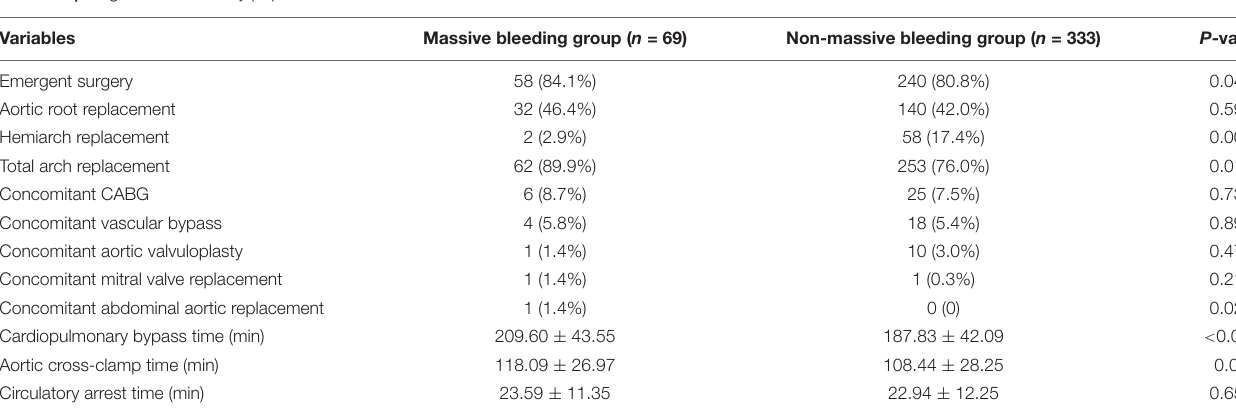
TABLE 2 | Surgical data of study